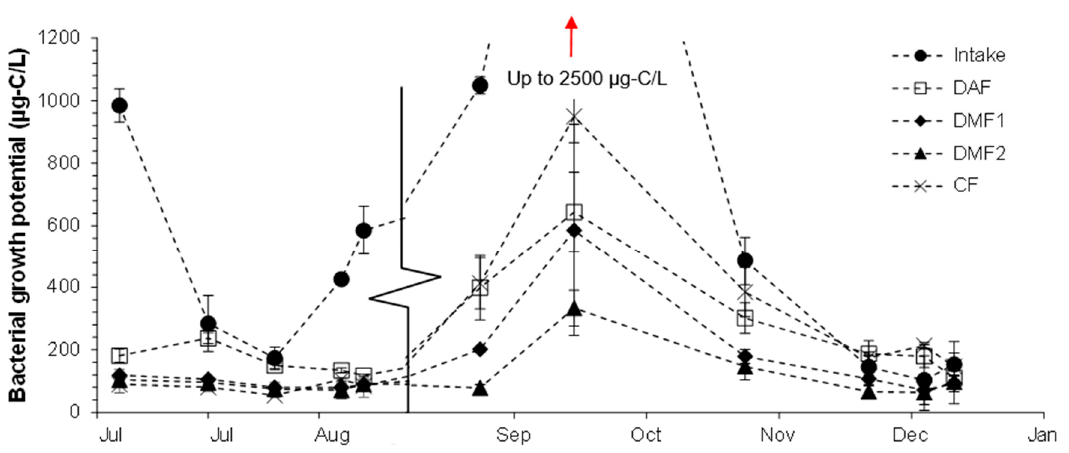
Figure 3. BGP along the pre-treatment of the SWRO desalination